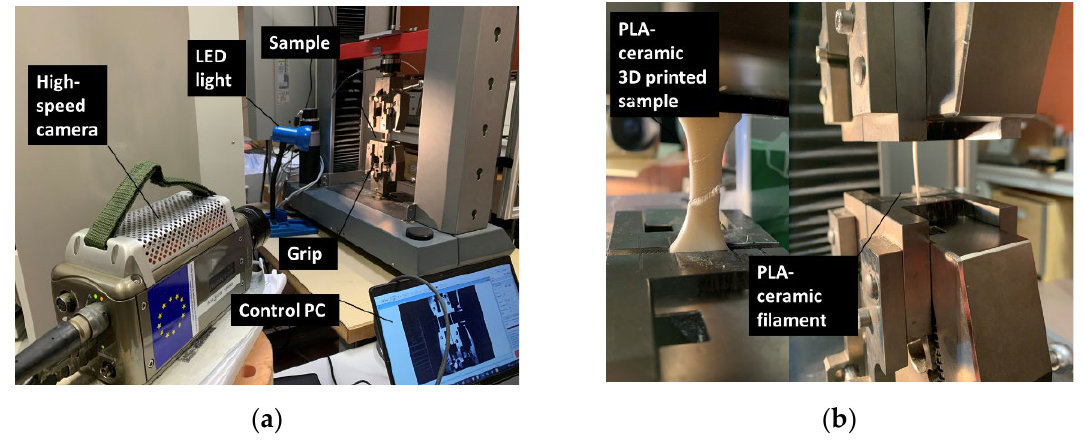
Figure 3. Tensile mechanical testing: ( a ) Experimental testing setup; ( b ) close-up view of filament and 3D-printed PLC sample.